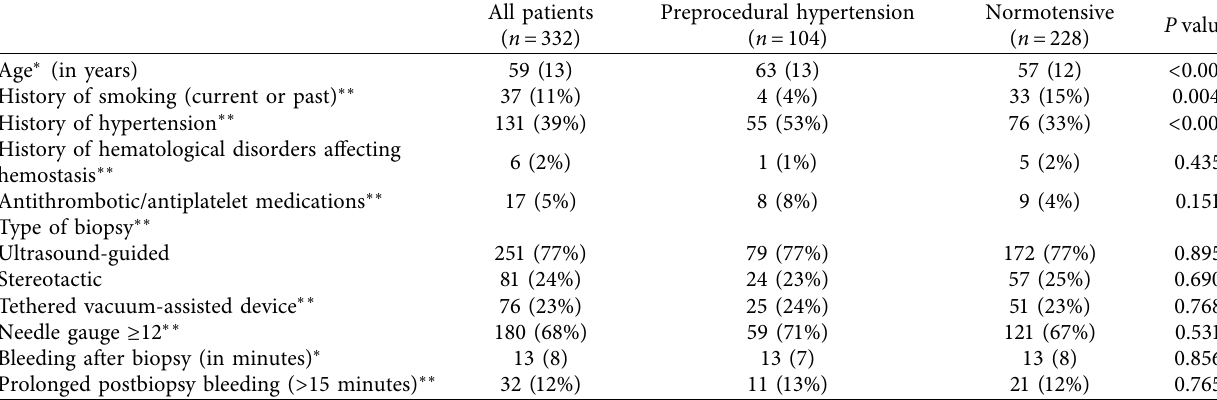
Table 1: Demographic and clinical characteristic of subjects by preprocedural